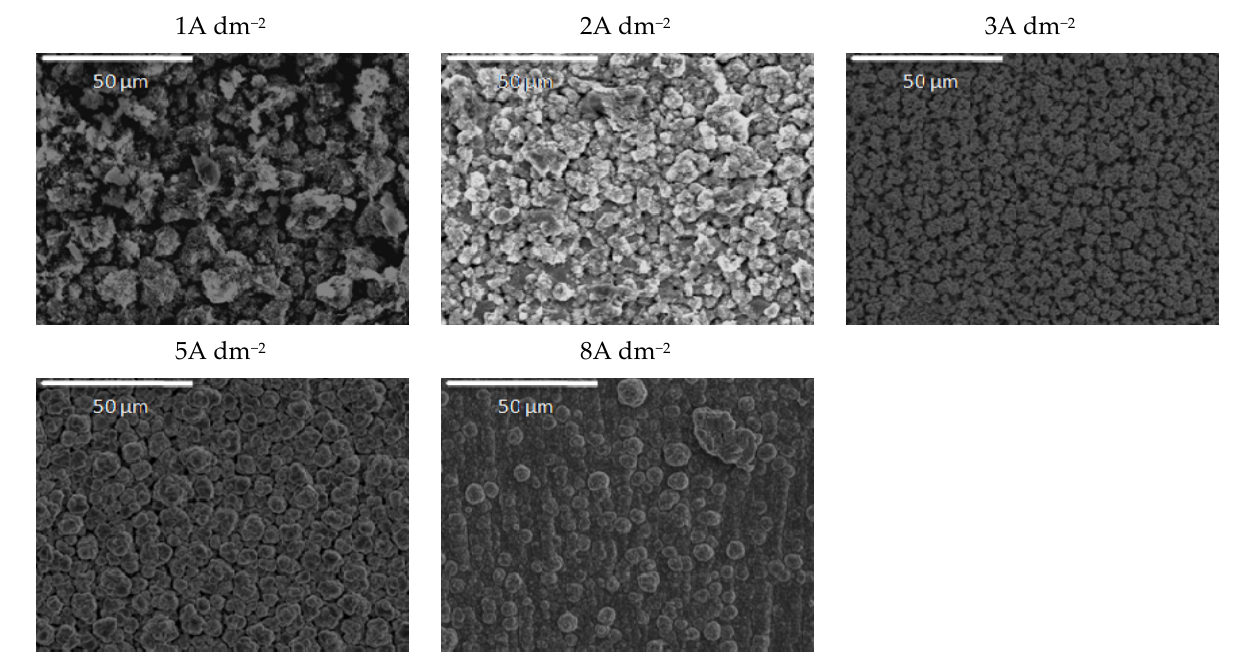
Figure 10. Morphology of the Zn-Co-CeO 2 composite coatings ultrasounddeposited at different current densities from the plating solution with 0.2 wt.% ceria powder.